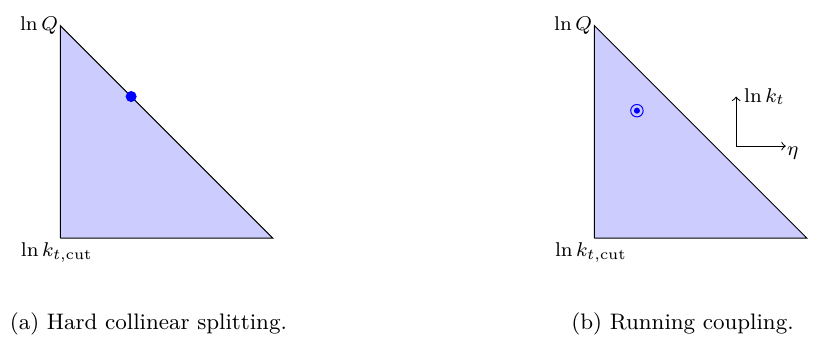
Figure 1 . Lund representation of the NDL configurations that are identical in e + e − collisions and pp